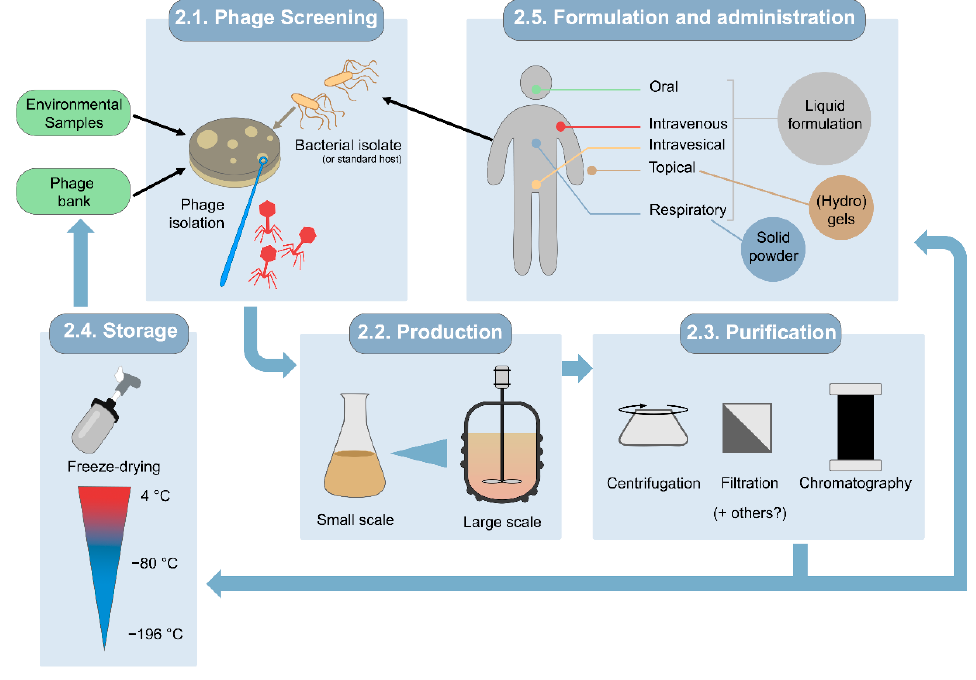
Figure 1. Steps in preparation of phage suspensions suitable for phage therapy, including screening, propagations, purification, storage, and formulation.